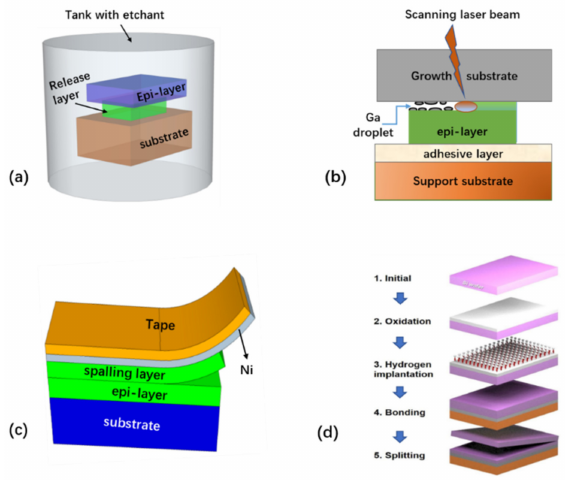
Figure 1. Sketches of common layer transfer techniques: ( a ) chemical epitaxial lift-off, ( b ) laser lift-off, ( c ) mechanical spalling, and ( d ) ion